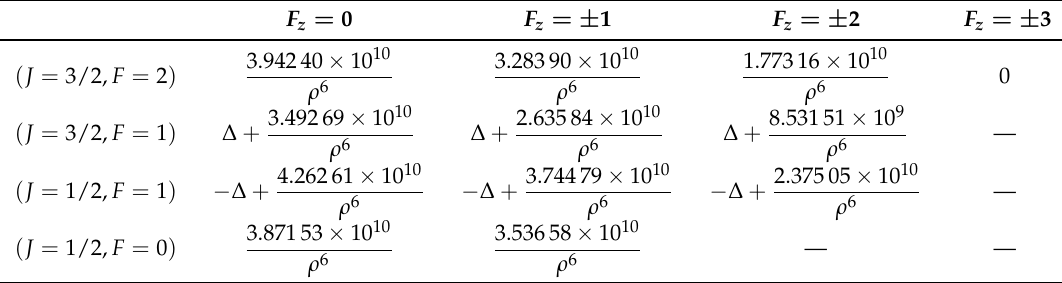
Table 4. Average second-order van der Waals shifts for 6 P J hydrogen atoms interacting with 2 S metastable atoms. Entries marked with a long hyphen (—) indicate unphysical combinations of F and F z values. We denote the scaled interatomic distance by ρ = R / a 0 and give all energy shifts in atomic units, i.e., in units of the Hartree energy E h = α 2 m e c 2 . The notation ∆ is defined in Equation (16). F z = 0 F z = ± 1 F z = ± 2 F z = ±